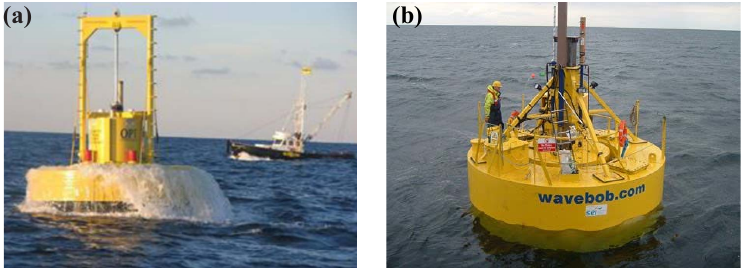
Figure 7. The OPT PowerBuoy device [106] and the Wavebob device [107] are shown as typical examples of self-reacting two-body PAs in ( a , b ),